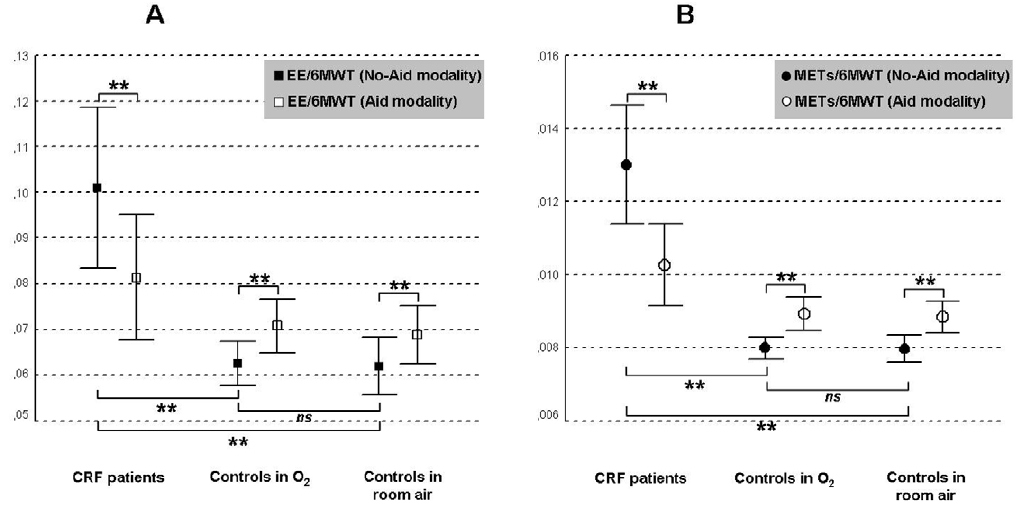
Figure 4. Comparison of EE outcomes recorded during both assisted ( Aid ) and unassisted (No- Aid ) walking in both CRF patients ( panelA ) and Controls ( panelB ) (for details see Methods). **p , 0.001 , ns: not significant .